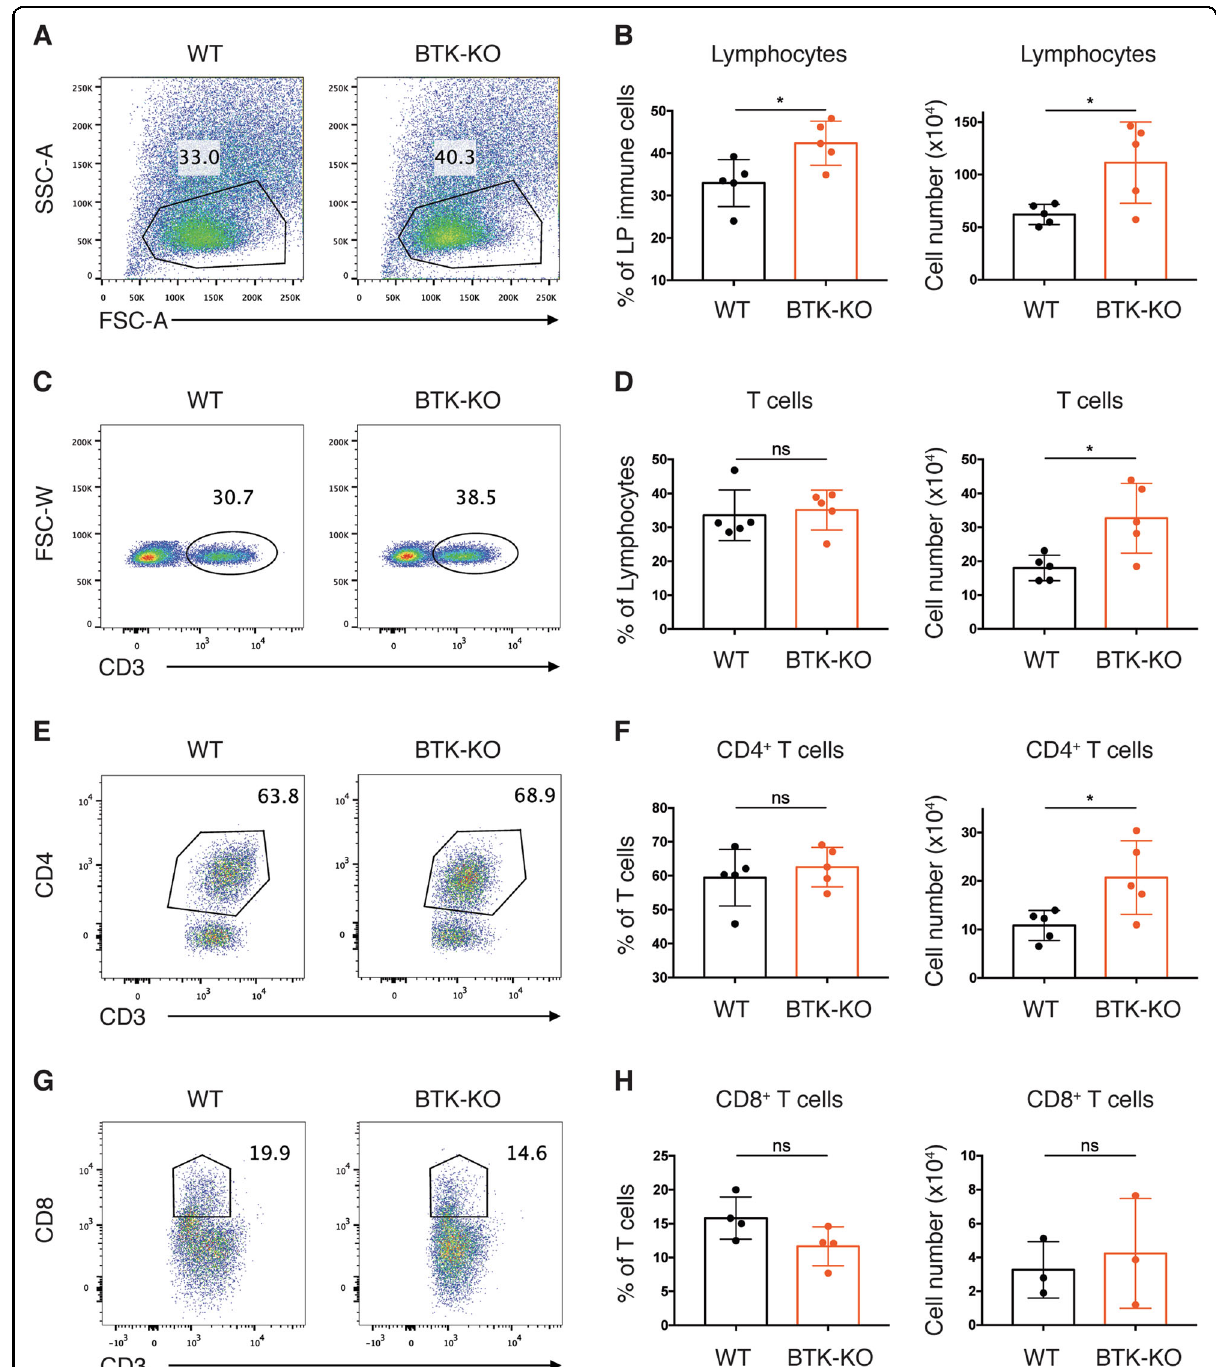
Fig. 3 Increase in CD4 + T cell population in the gut LP of BTK-KO mice. A Colon LP immune cells from WT and BTK-KO mice gated for lymphocytes. Numbers shown are percentage of cells in the indicated gates. B Frequency (left) and total number (right) of lymphocytes in the immune cells from the colon LP of WT and BTK-KO mice. C Colon LP lymphocytes from WT and BTK-KO mice stained as indicated to reveal T cells. Numbers shown are percentage of cells in the indicated gates. D Frequency (left) and total number (right) of T cells in lymphocytes from colon LP of WT and BTK-KO mice. E Colon LP T cells from WT and BTK-KO mice stained as indicated to reveal CD4 + T cells. Numbers shown are percentage of cells in the indicated gates. F Frequency (left) and total number (right) of CD4 + T cells in total T cells from colon LP of WT and BTK-KO mice. G Colon LP T cells from WT and BTK-KO mice stained as indicated to reveal CD8 + T cells. Numbers shown are percentage of cells in the indicated gates. H Frequency (left) and total number (right) of CD8 + T cells in total T cells from colon LP of WT and BTK-KO mice. Data are presented as mean ± SD ( n = 3 – 5). Statistical signi fi cance was determined by two-sided independent sample Student ’ s t test. ns: not signi fi cant; * P < 0.05, ** P < 0.01 and *** P <